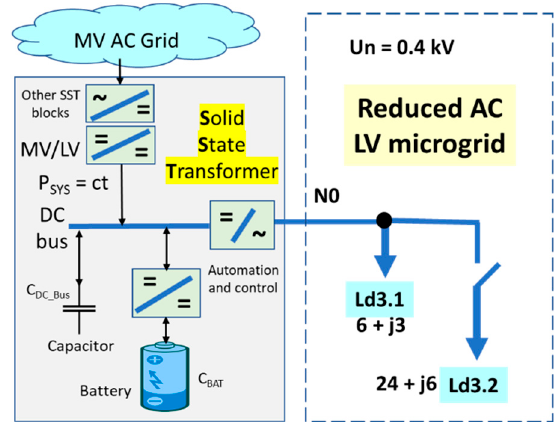
Figure 6. Simplified microgrid for longer term stability analysis.